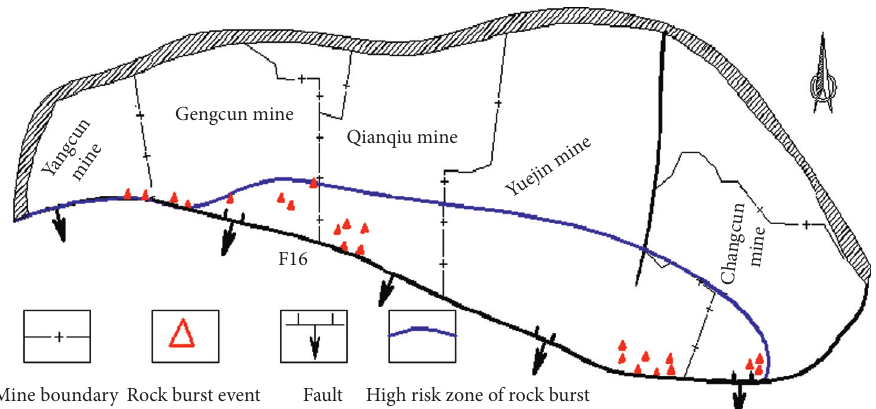
Figure 4: Distribution of high incidence area of rock burst in Yima coalfield.